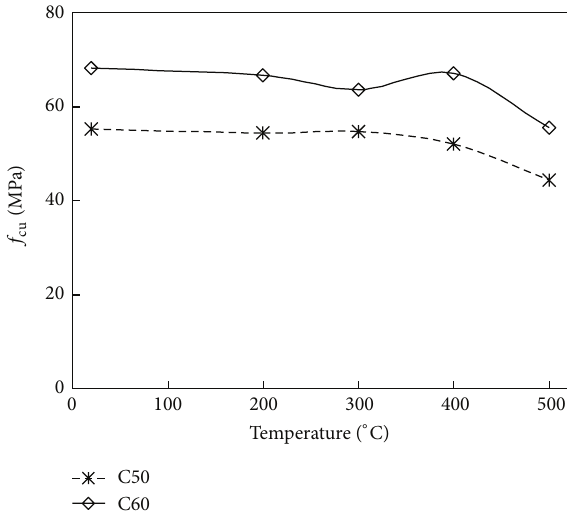
Figure 4: The variation of the cubic compressive strength with time.